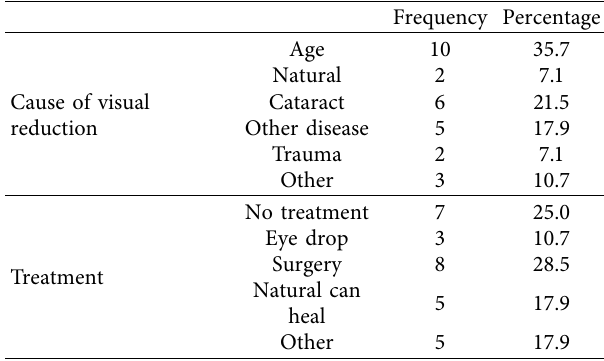
Table 4: Patients view on cause and treatment of cataract in South Ari, Southern Ethiopia, in December 2021 ( n �